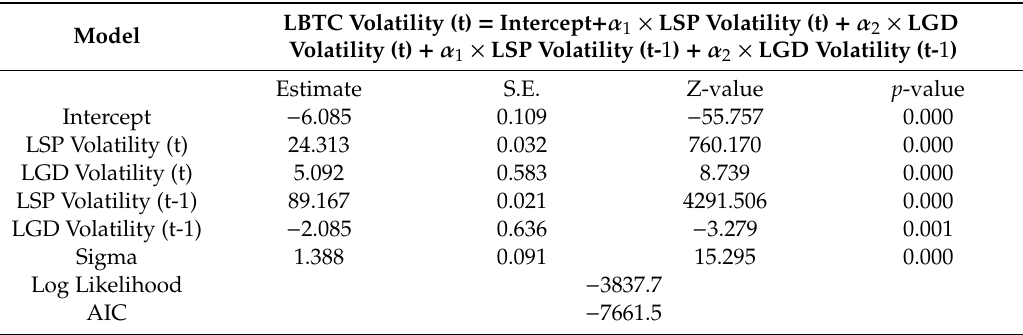
Table 11. With nonlinear asymmetric GARCH (1, 1) volatilities, GCMR model fit of LBTC volatility with LSP volatility(t), LGD volatility (t), volatility (t-1) and LGD volatility (t-1) with error dependence structure ARMA (0,